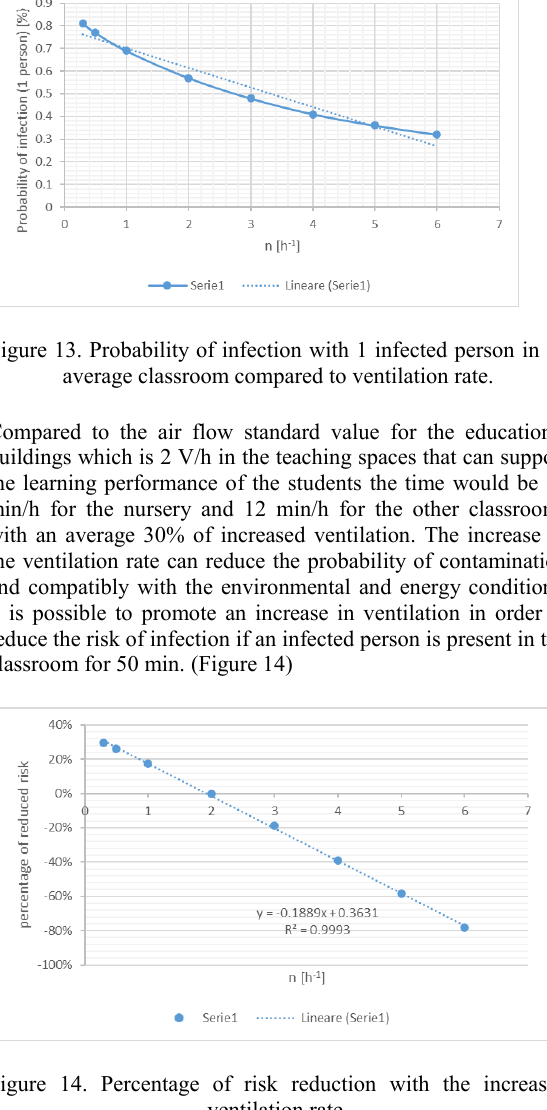
Figure 14. Percentage of risk reduction with the increased ventilation